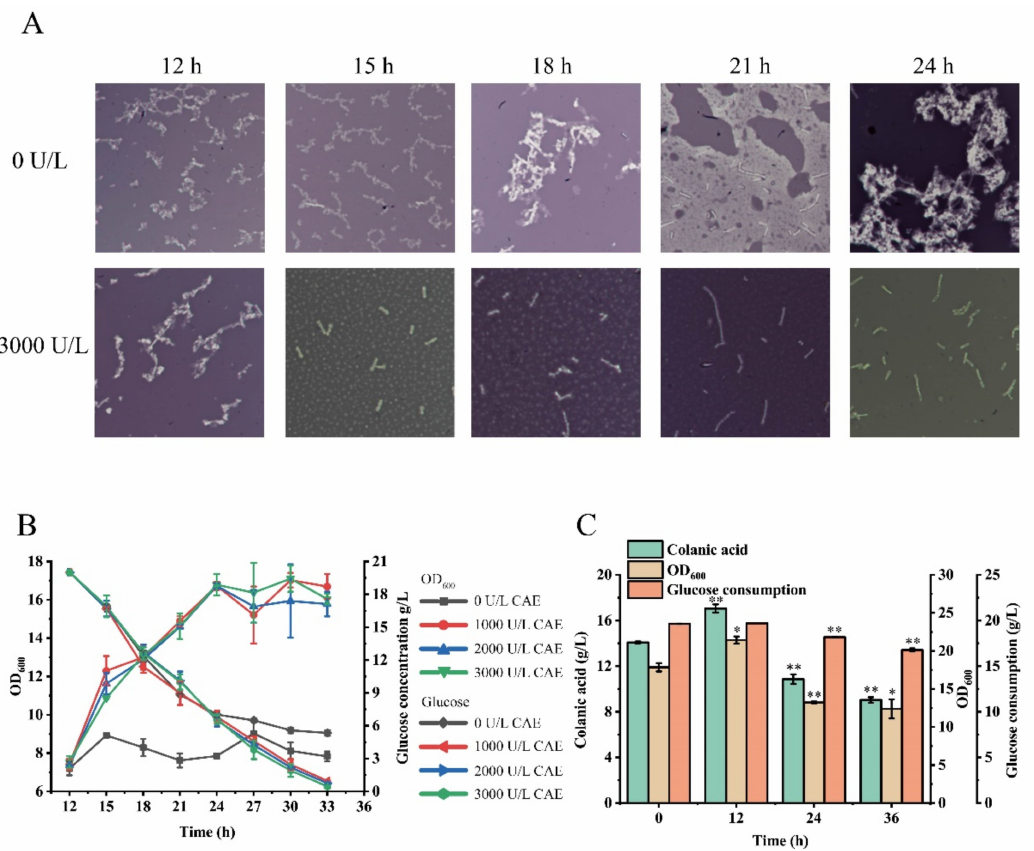
Figure 6. Colanic acid capsule layer inhibited strain growth and glucose acquisition. ( A ) The formation of the colanic acid capsule and the disruption of the colanic acid capsule after adding the hydrolase. ( B ) The growth and glucose consumption of the SRP-4 strain at 30 ◦ C in shake flasks after adding different amounts of colanic acid hydrolase. ( C ) The colanic acid titers of the SRP-4 strain after adding 4000 U/L hydrolase at different times. Statistical data analysis was performed with t-texts in SPSS 25.0. p values of <0.05 were considered statistically significant, and statistical significance is indicated as * for p < 0.05 and ** for p <